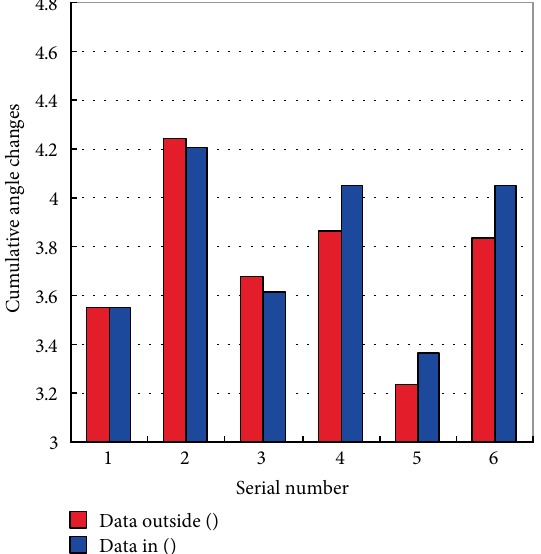
Figure 7: A comparison chart of Δ𝜃 sum when there is an